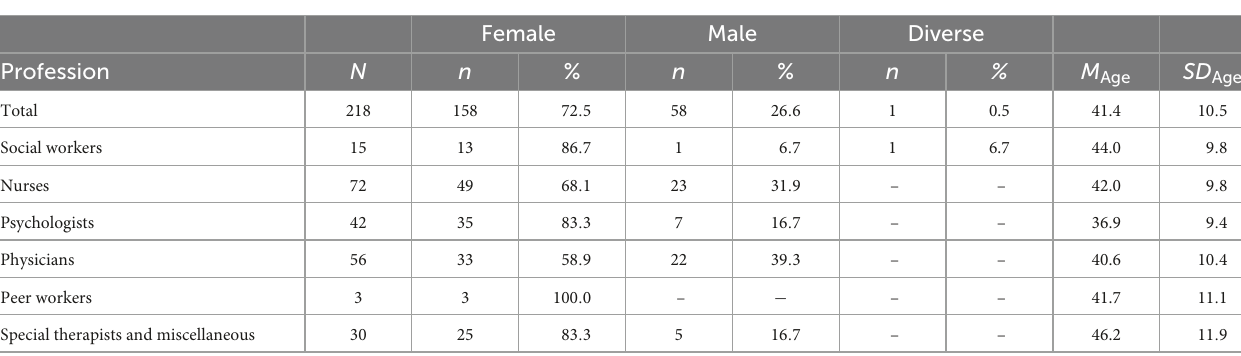
TABLE 1 Sample characteristics.